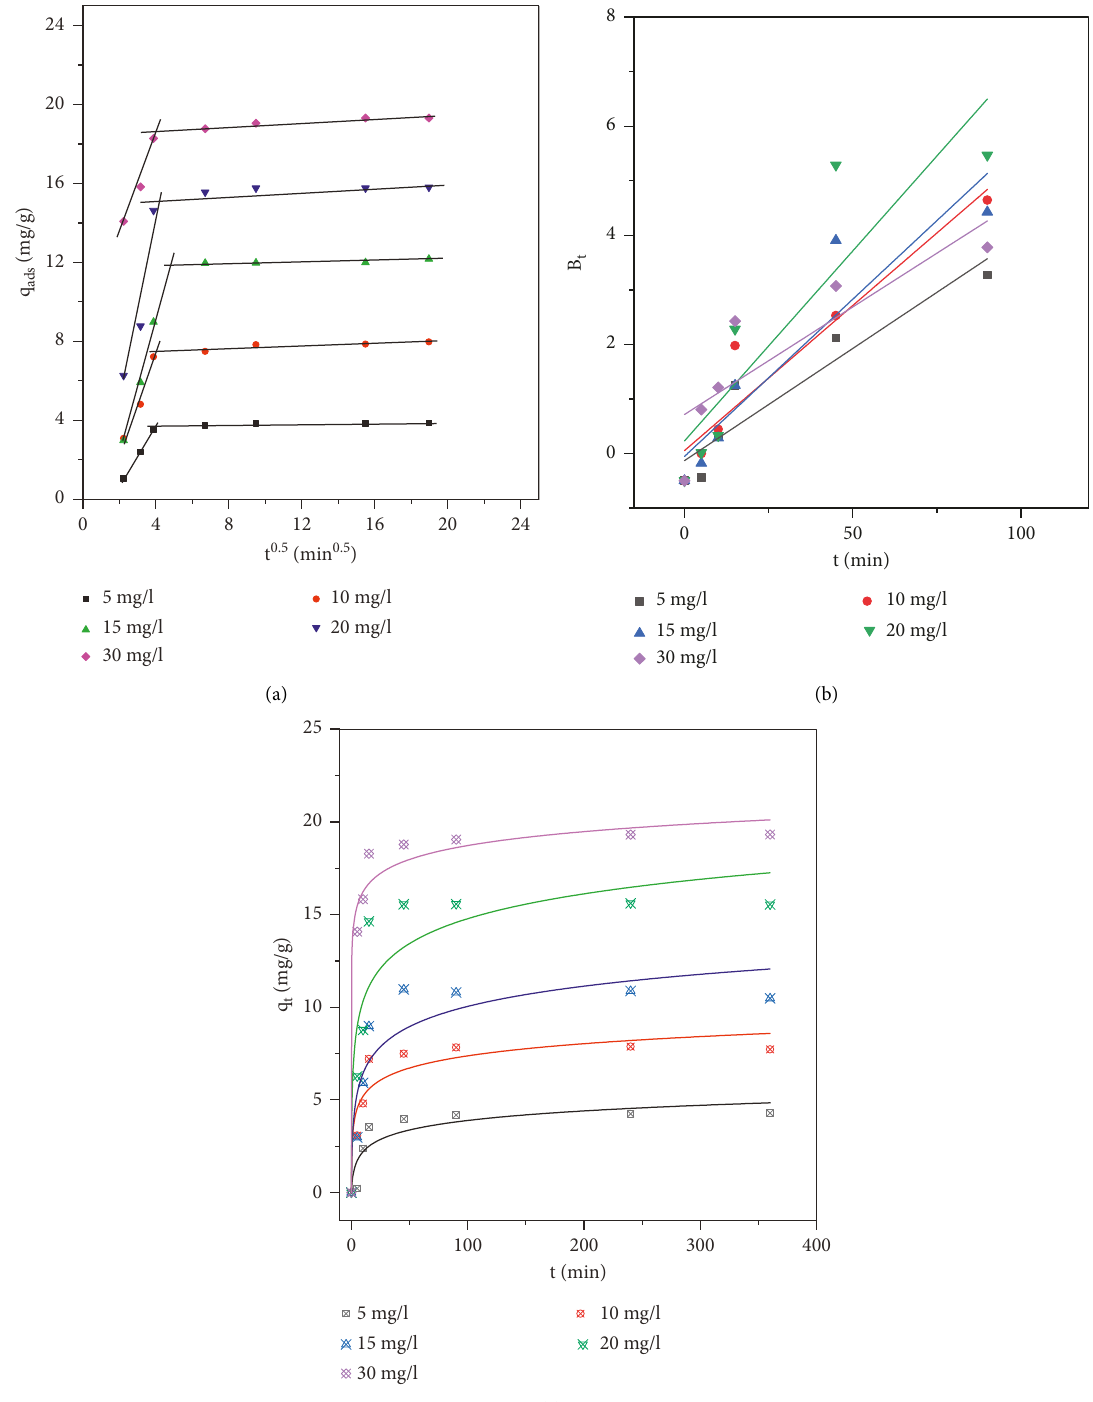
Figure 11: (a) Intraparticle diffusion model, (b) Boyd model, and (c) Elovich model for the MB adsorption on